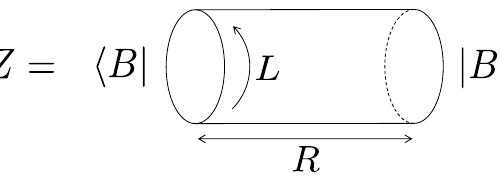
Figure 1 . The cylinder partition function with circumference L and length R . It admits two di(cid:11)erent expansions; the closed string channel (2.1) in which R plays the role of time, and the open string channel (2.4) in which L plays the role of time. Equating two expansions in the R ! 1 , we obtain the TBA formulation for the g -function